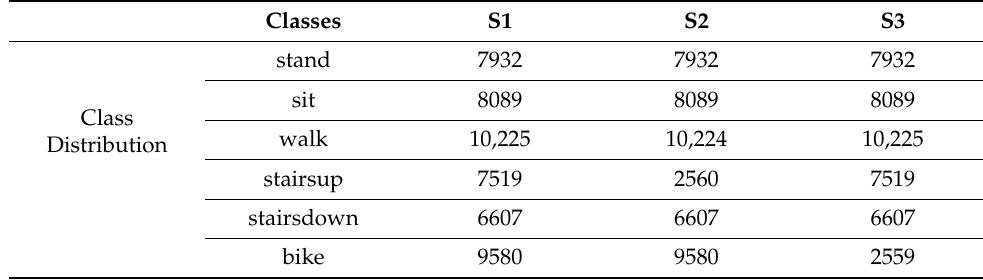
Table 9. The class distribution of D H